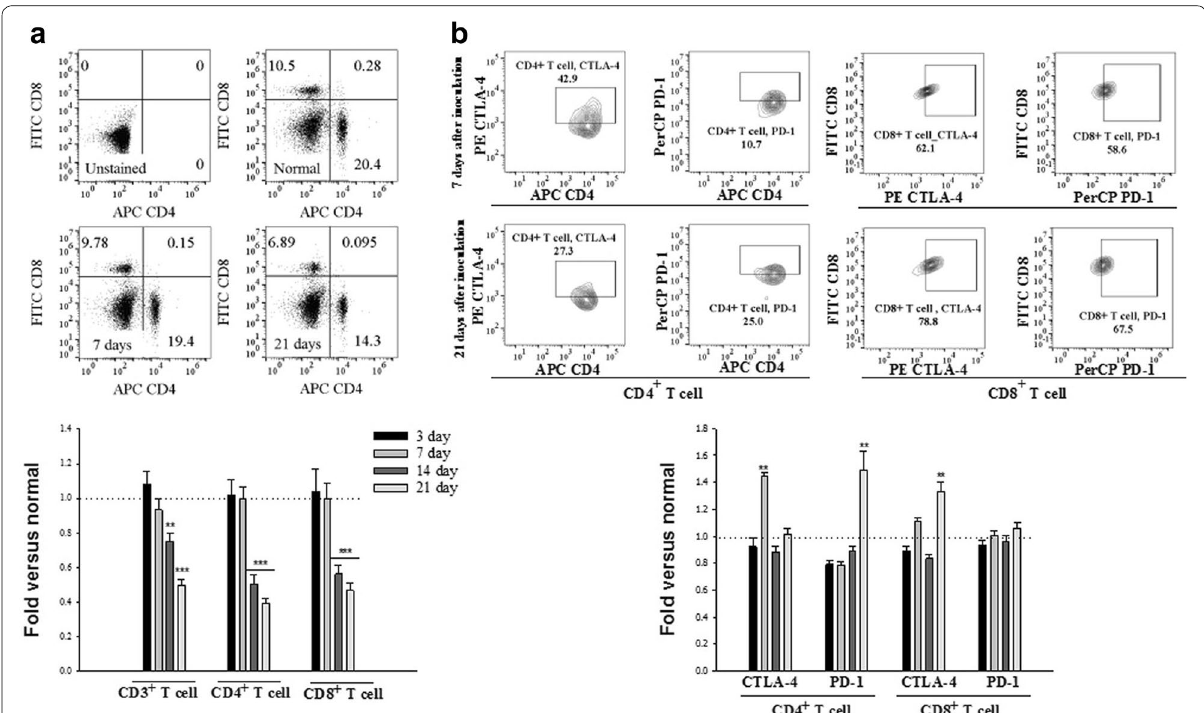
Fig. 4 Immunological changes during cachexia progression. At 3, 7, 14, and 21 days after C26 cell inoculation, mice were sacrificed and their spleen was extracted. The populations of a CD3 + , CD4 + , and CD8 + T cells and b immune checkpoint molecules including CTLA‑4 and PD‑1 on CD4 + and CD8 + T cells in spleen were analyzed by flow cytometry. The bar graph represents the fold‑change values of the cachexia group versus the normal group, with standard error of the mean. Dotted lines indicate the normal group fold‑change. ** P < 0.01 and *** P < 0.001 versus 3 days after C26 cell inoculation. CTLA, cytotoxic T‑lymphocyte‑associated antigen‑4; PD‑1, programmed cell death protein